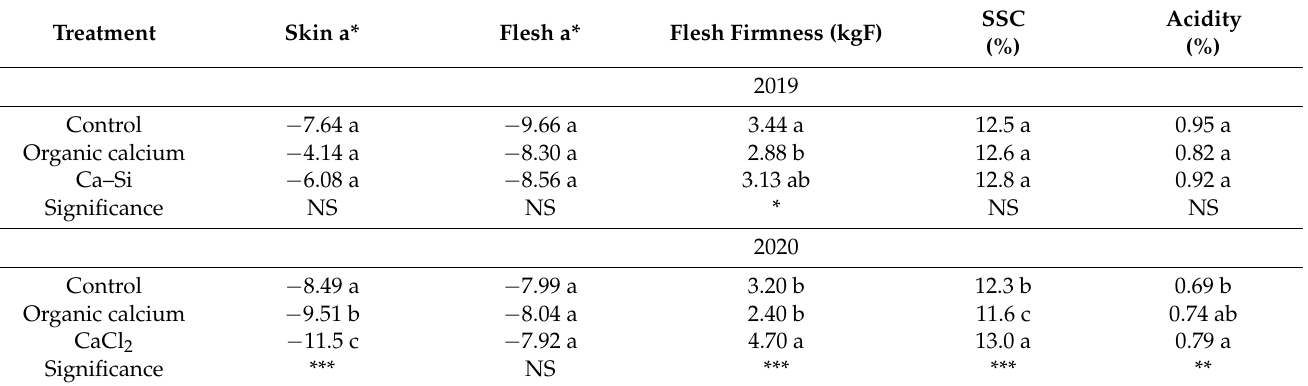
Table 2. The effect of calcium formulation application on the fruit quality at Agios Vlasios orchard. Ca–Si: calcium and silicon